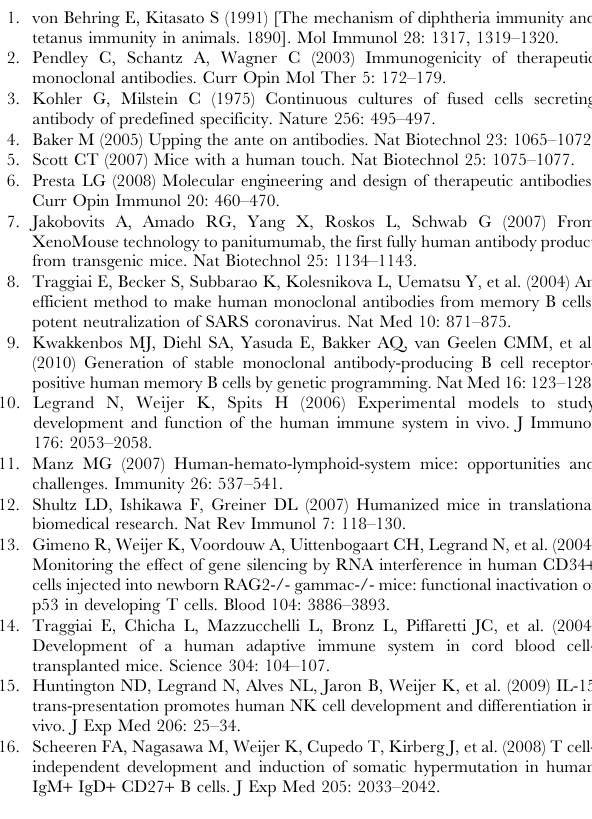
Table S3 IgM V H amino-acid sequence of generated HBsAg- specific B cell clones. The germ-line sequence is given for each V H family, with indication of framework regions (FR) and comple- mentary determining regions (CDR). Highlighted amino-acids correspond to N-additions (in the CDR3 region) and somatic hyper-mutation events, whether it results in a silent mutation (green) or not (red). Clones with identical BCR sequences are grouped together. Table S4 IgM V H amino-acid sequence of generated TT- specific B cell clones. Data are presented as in the Table